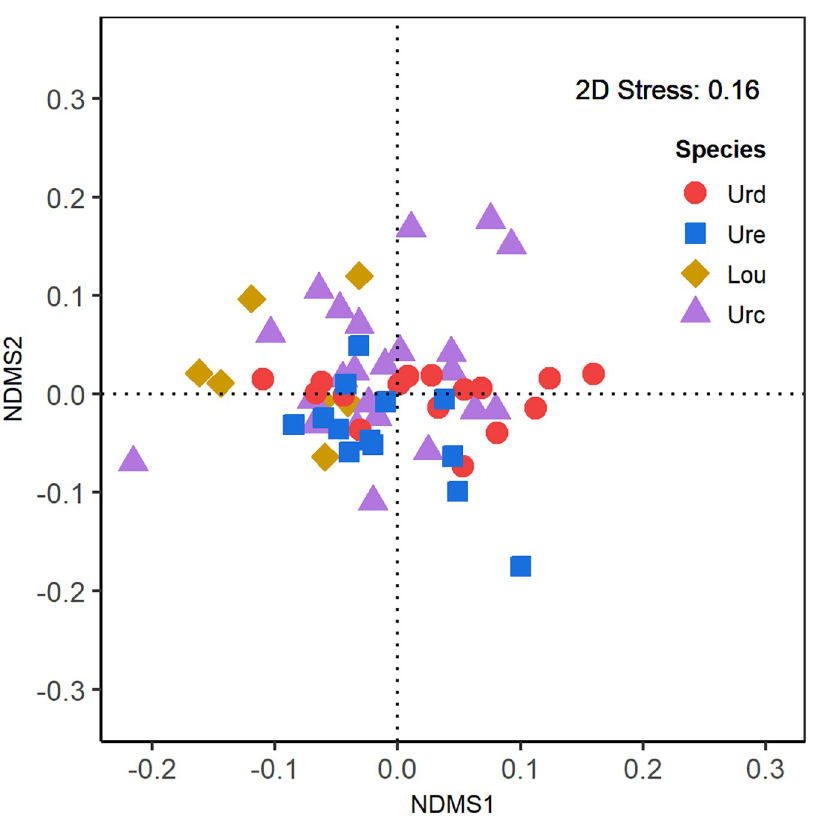
Fig 2. Non-metric multidimensional scaling (nMDS) ordination of fatty acid composition among Uroteuthis duvaucelii , Uroteuthis edulis , Uroteuthis chinensis and Loliolus uyii in the northern South China Sea. Urd, Uroteuthis duvaucelii ; Ure, Uroteuthis edulis ; Lou, Loliolus uyii ; Urc, Uroteuthis chinensis .